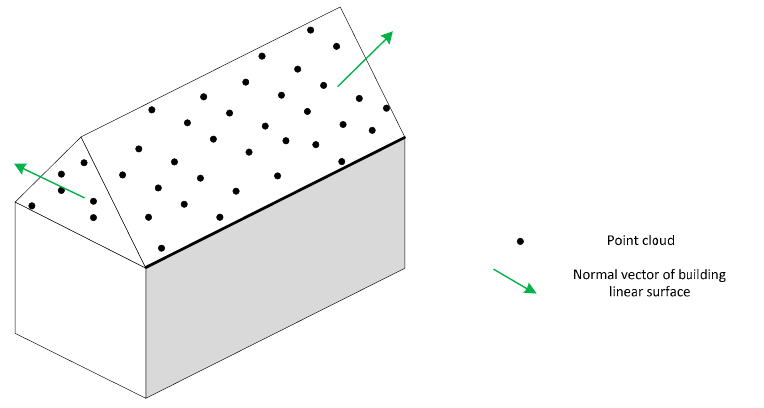
Figure 1. The normal vector of plane roof facets on a building.